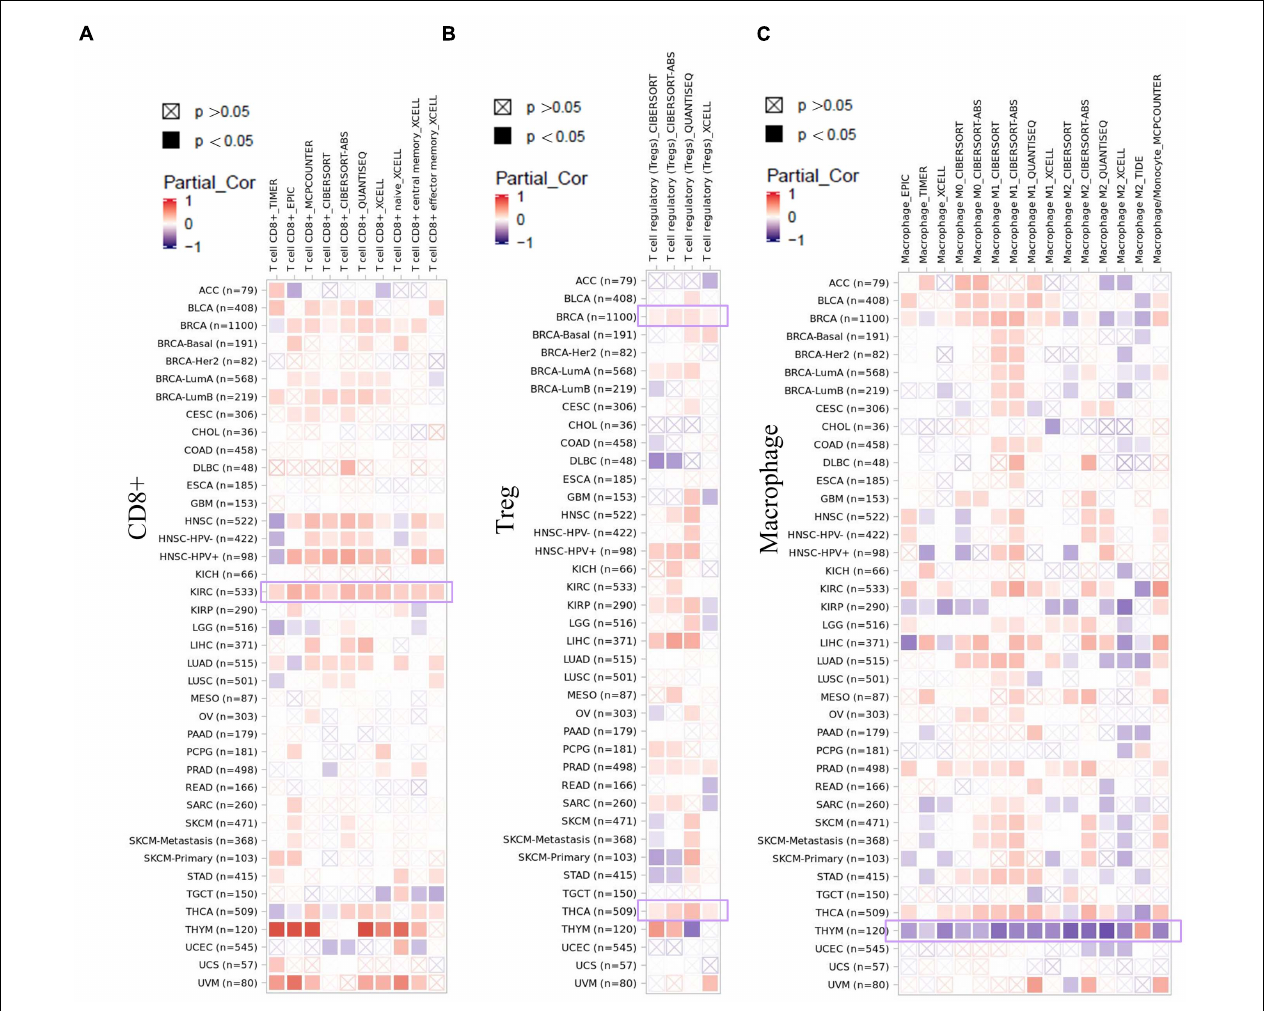
FIGURE 7 | Correlation analysis between EZH2 expression and immune infiltration of (A) CD8+, (B) tregs, and (C) macrophages.